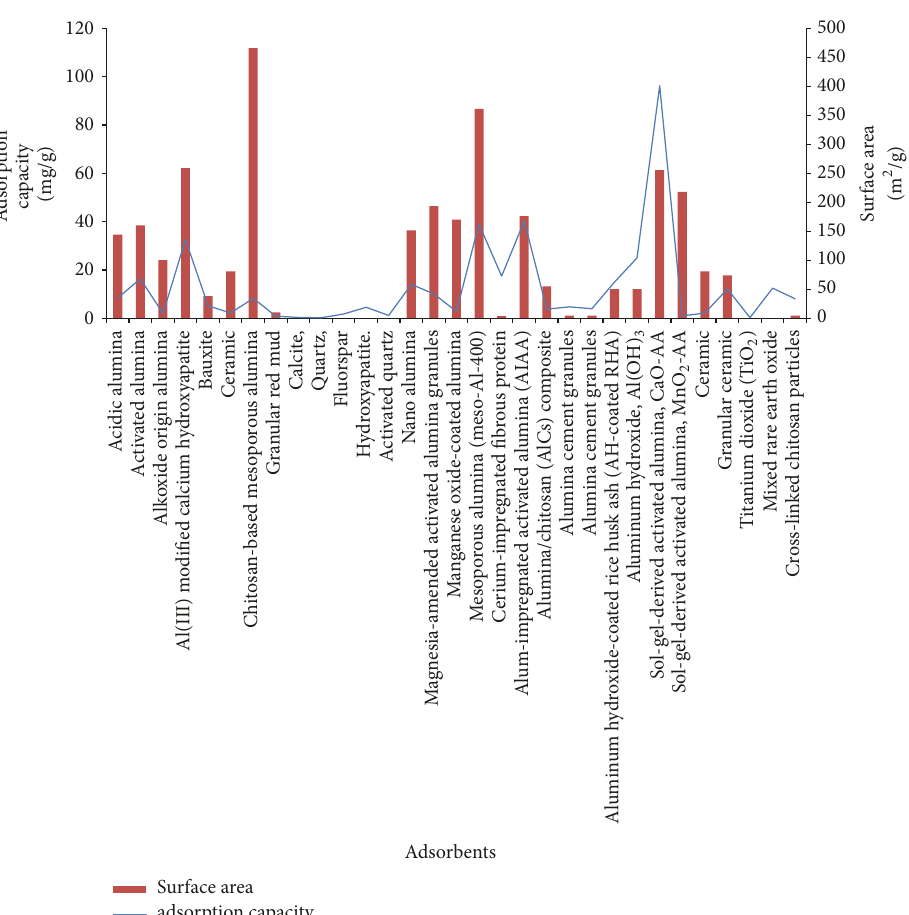
Figure 4: Relationship between the adsorption capacity and surface area of the adsorbents for fluoride